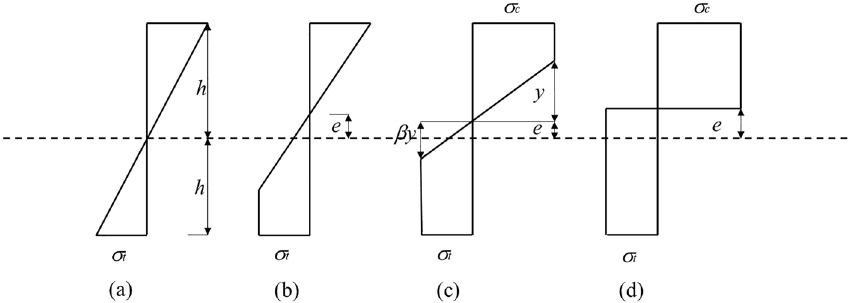
Figure 2. Elastic–plastic evolution diagram of roof beam section: ( a ) elastic stage; ( b ) first elastic–plastic stage; ( c ) second elastic–plastic stage; ( d ) plastic